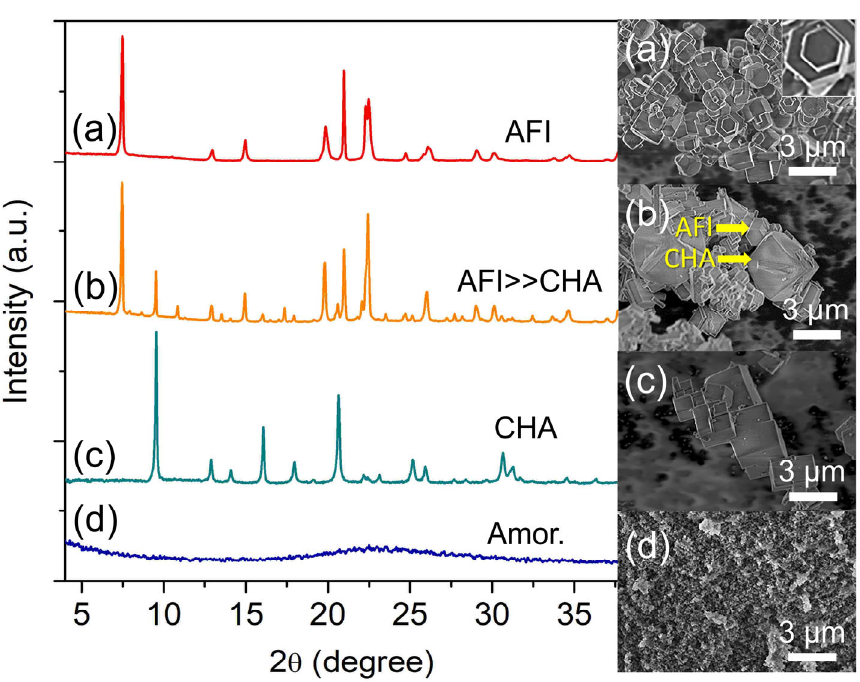
Figure 4. XRD patterns and FESEM micrographs of ( a ) S-11 ( y = 5.3), ( b ) S-12 ( y = 6.0), ( c ) S-3 ( y = 6.7), and ( d ) S-13 ( y = 7.4) samples. The samples were prepared using the hydrogel of 2.0 Al: 4.7 P: 0.9 Si: y [PrPy]OH: 148 H 2 O heated at 200 ◦ C for 19 h.